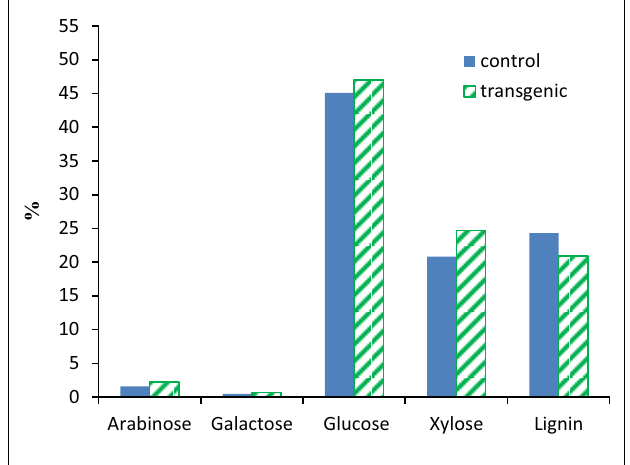
FIGURE 1 | Compositions of wild-type and COMT down-regulated switchgrass (internode I1) . Contents expressed on a dry weight